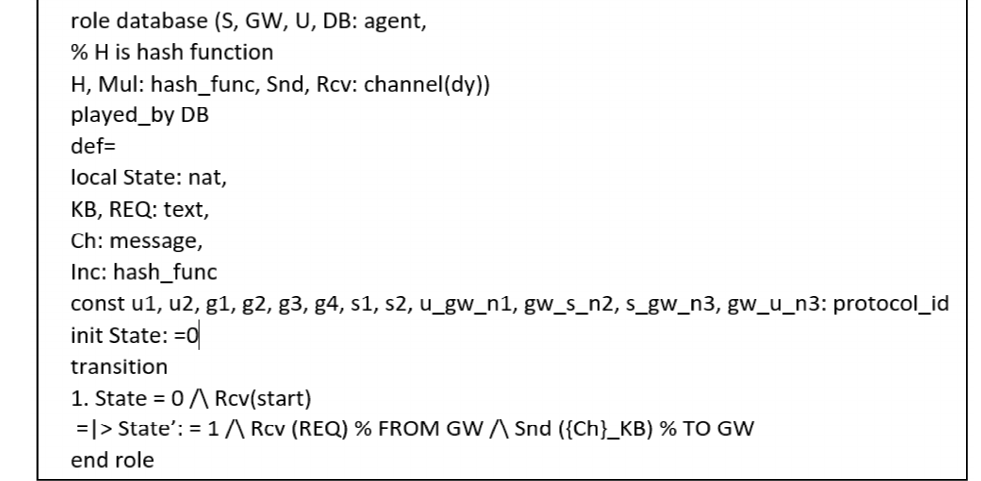
Figure A4. Role of the database.